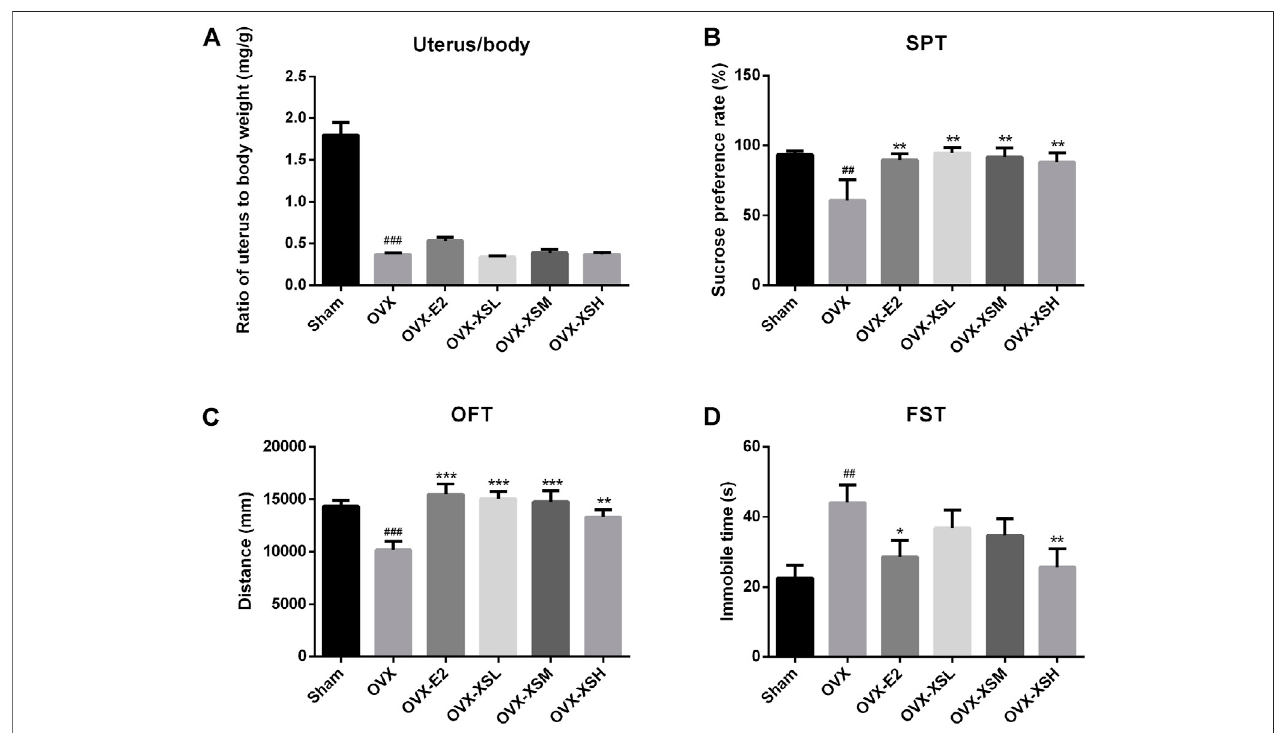
FIGURE 5 | Effects of XS volatile oil and estradiol treatment on behavior parameters in OVX rats. (A) Ratio of uterus to body weight. (B) Sucrose preference test (SPT). (C) Open- fi eldtest(OFT). (D) Forcedswimtest(FST).Datawererepresentedasmean ± SEM; n (cid:2) 6 – 10pergroup.OVX-E2(estradiolvalerate,0.18 mg/kg),OVX- XSL (10.8 mg/kg), OVX-XSM (32.4 mg/kg), OVX-XSH (97.2 mg/kg). ## p < 0.01, ### p < 0.001 compared with the sham group; * p < 0.05, ** p < 0.01, *** p < 0.001 compared with the OVX